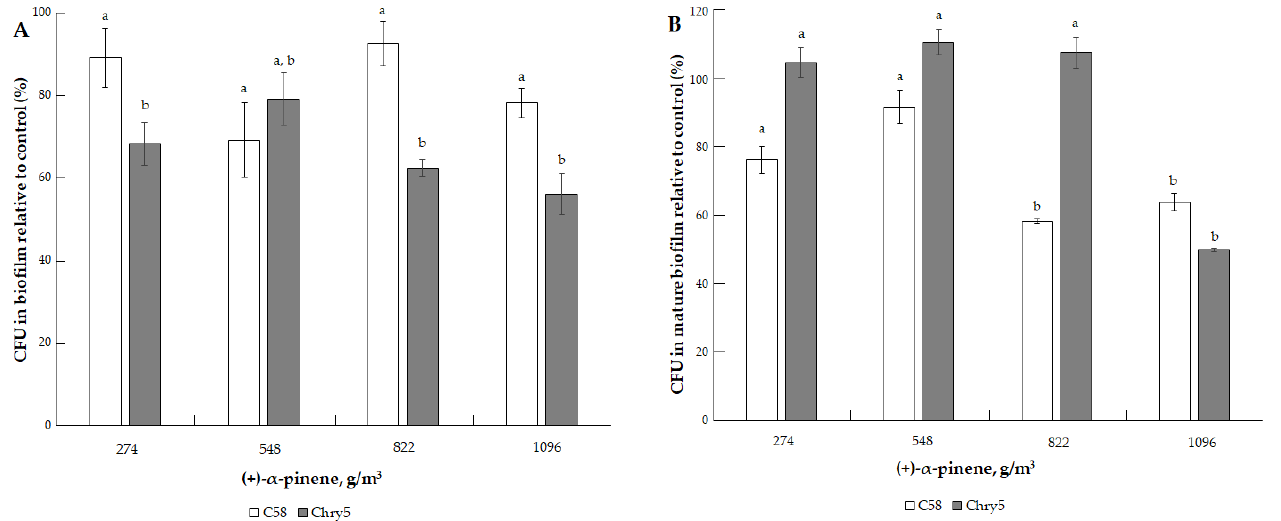
Figure 8. The effect of (−) -limonene on the formation of biofilm of A. tumefaciens C58 (white col- umn) and Chry5 (gray column) ( A ) and cell survival in mature biofilms ( B ) depending on the conce ntration of (−) -limonene. CFU of bacteria strains in the control (without VOC): 100 a %. The different lowercase letters above the mean values indicate significant differences ( p ≤ 0.05; Tukey’s HSD test).